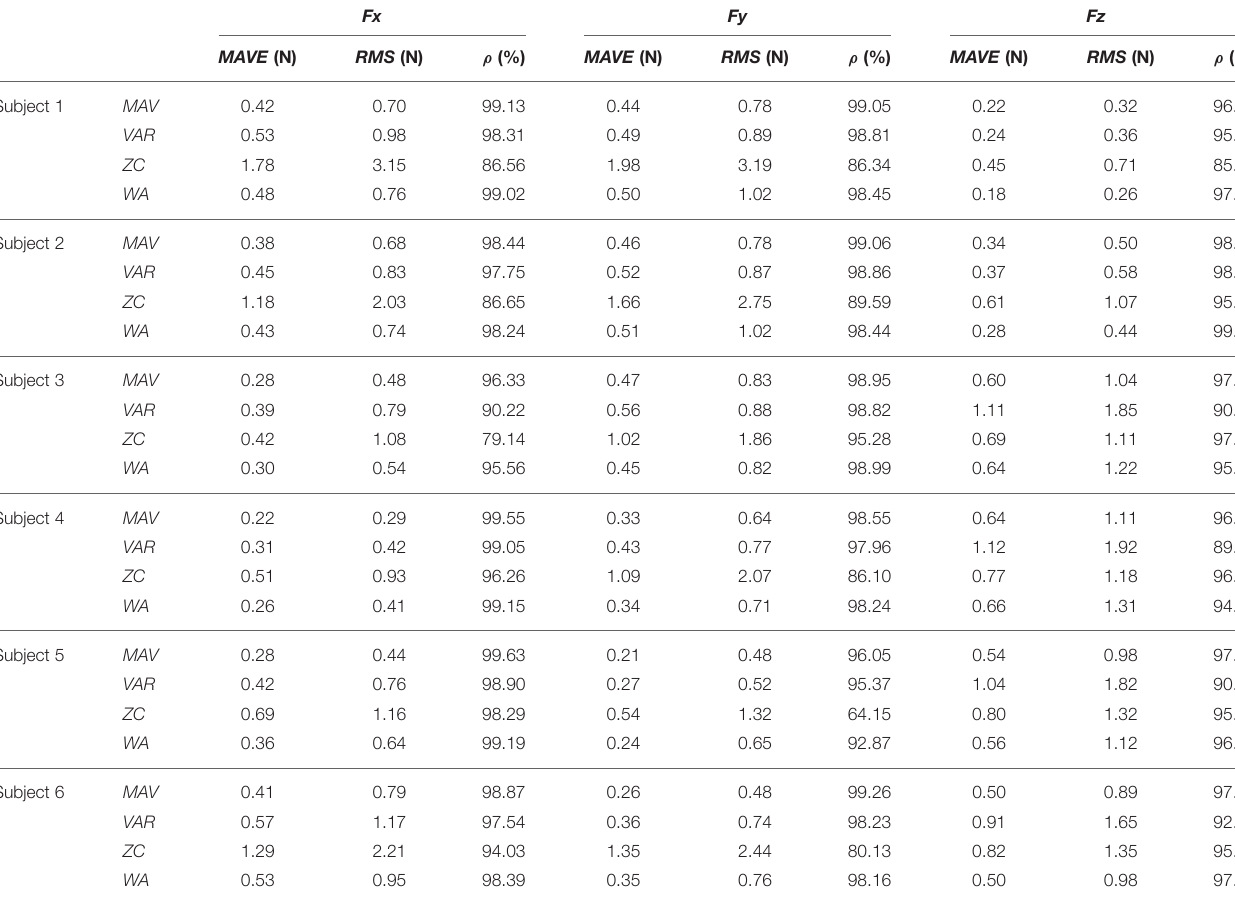
TABLE 9 | The results of the 3D force estimation experiments.